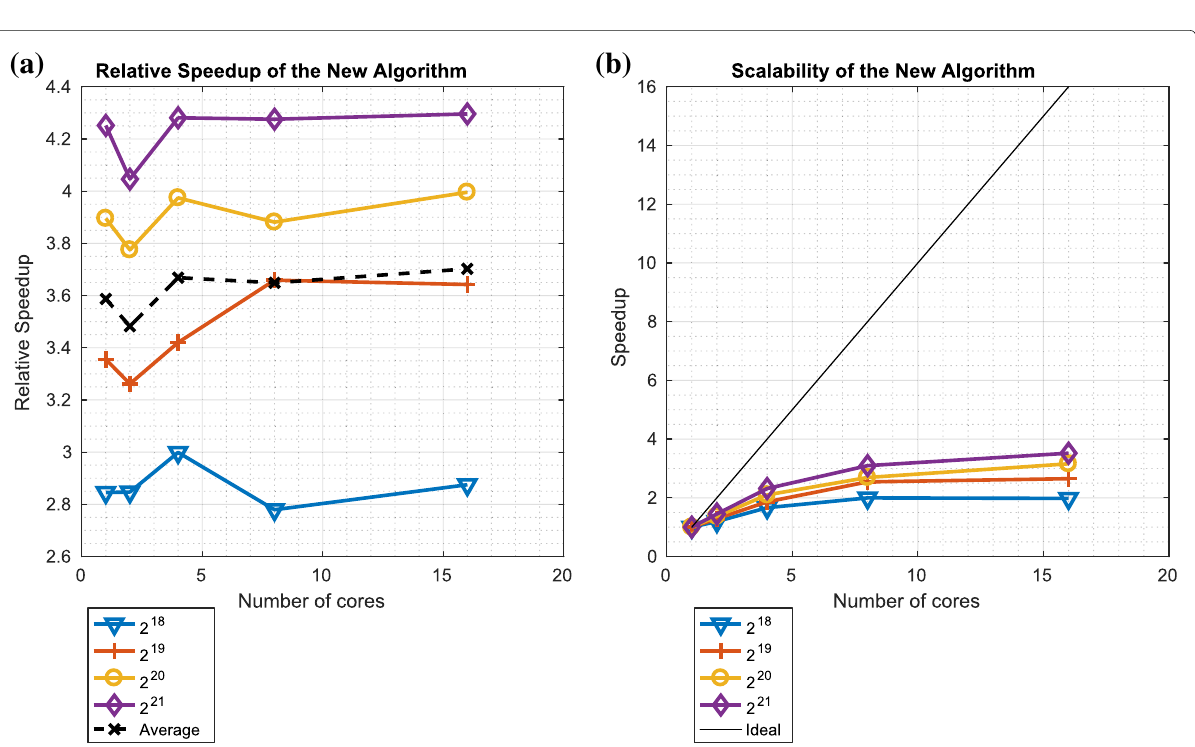
Fig. 16 Relative speedup and scalability of the overall particle filter algorithm using the O platform 1. a Relative speedup: O